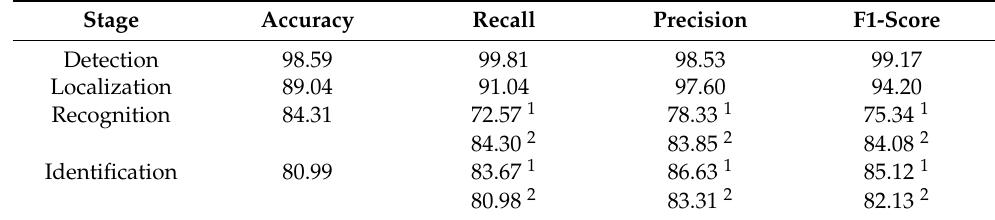
Table 7. The performance of the individual stage (values in